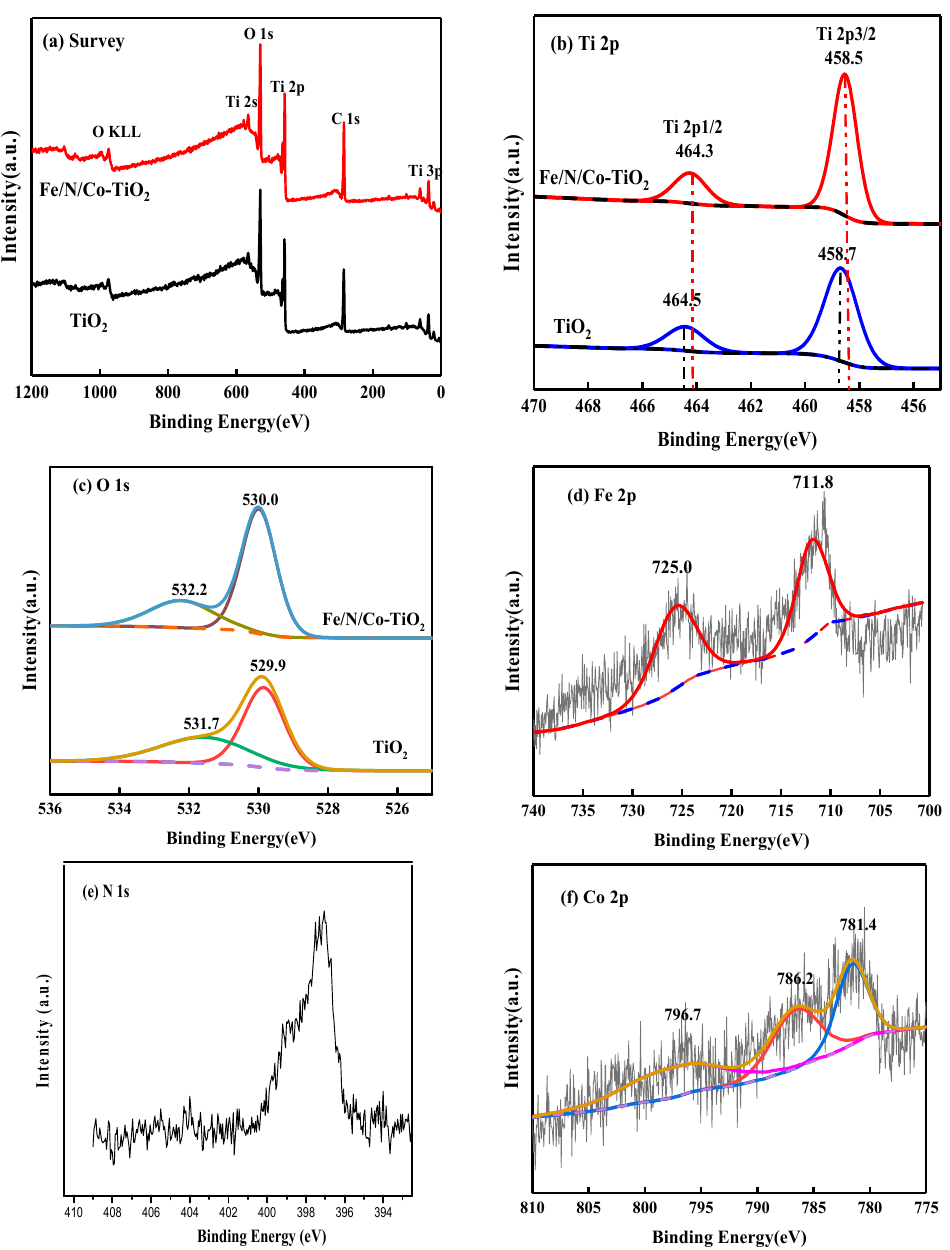
Figure 7. The XPS spectra: ( a ) survey, ( b ) Ti 2p, ( c ), O 1s, ( d ) Fe 2p, ( e ) N 1s, and ( f ) Co 2p of Fe/N/Co–TiO 2 and TiO 2 nanoparticles (NPs).